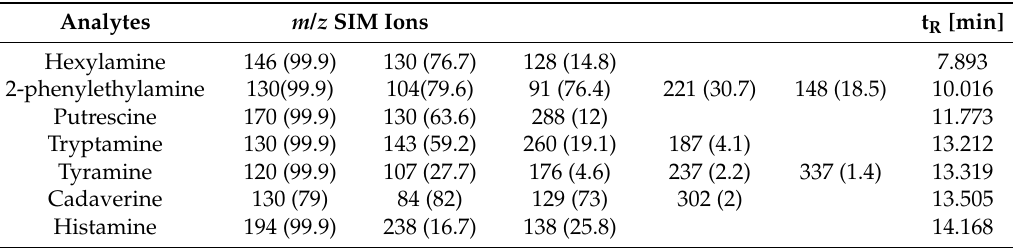
Table 4. Fragments, relative intensities, and retention time (t R ) of BAs obtained by application of GC-MS technique.